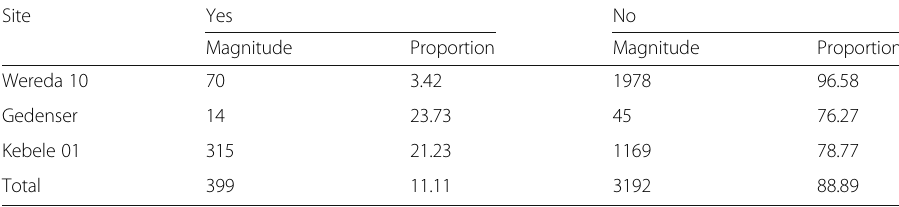
Table 4 Youth involvement on entrepreneurship